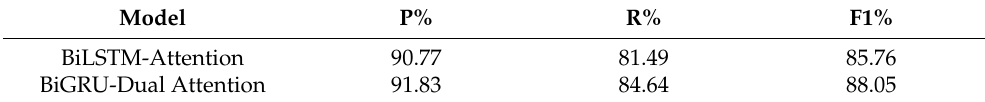
Table 8. Comparison between BiLSTM-Attention and BiGRU-Dual Attention.